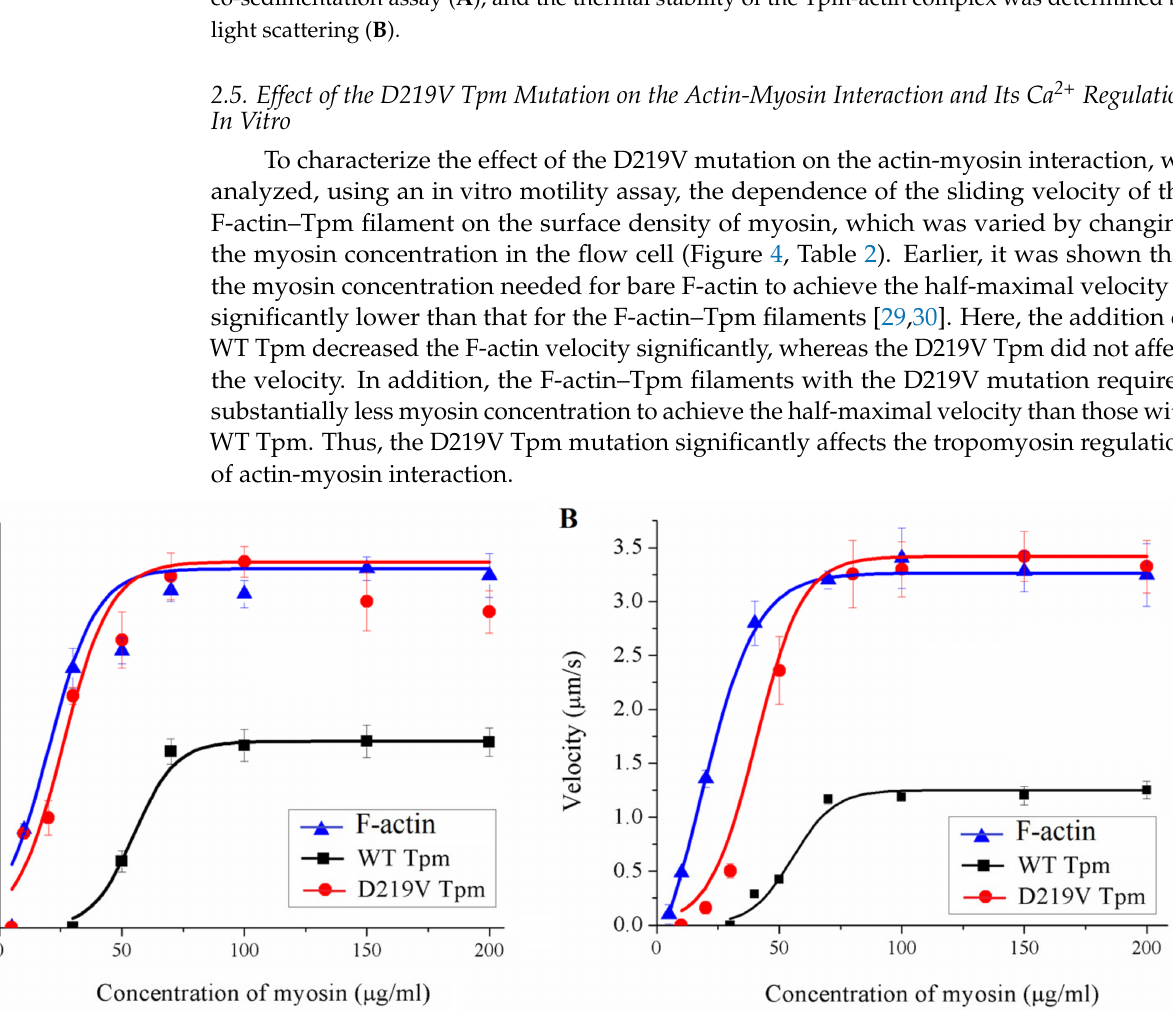
Figure 4. The effects of the D219V Tpm mutation on the dependence of the sliding velocity of the F-actin–Tpm filament on the concentration of ventricular ( A ) and atrial ( B ) myosin in the in vitro motility assay. Each data point represents the Mean ± SD from three experiments. The data are fitted with the Hill equation. The parameters of the Hill equation are presented in Table